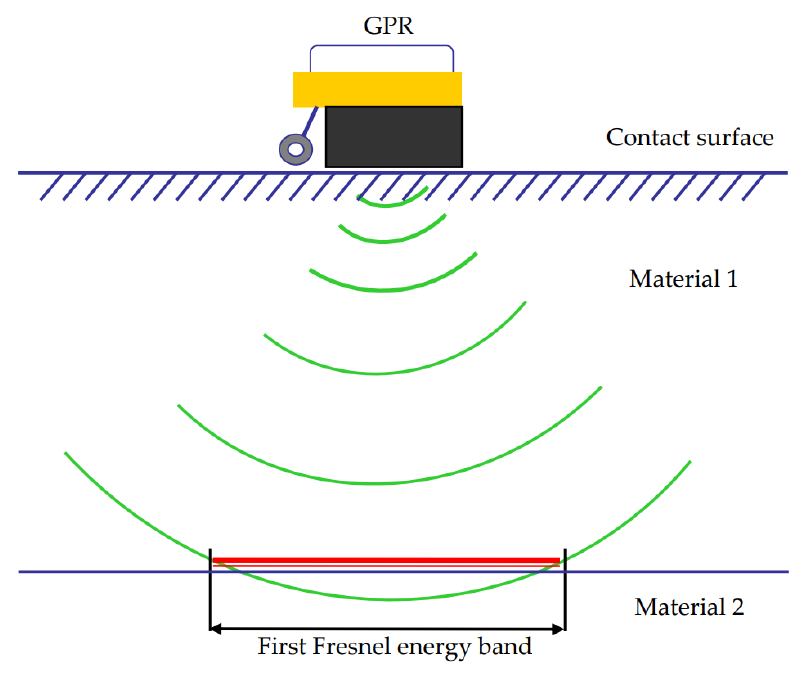
Figure 2. First Fresnel Energy Wave Band.